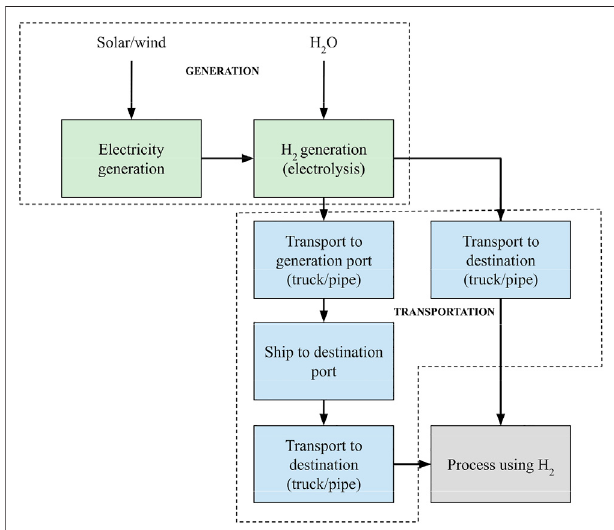
FIGURE 2 | Scope of the study showing the two main parts, H 2 production and transportation. Everything within the dotted lines is the scope of the study. Transport is either directly to the destination (if possible) by truck or pipeline, or else it is shipped from the nearest port to the closest port to the destination. If both transportation routes are possible, the more cost- effective is